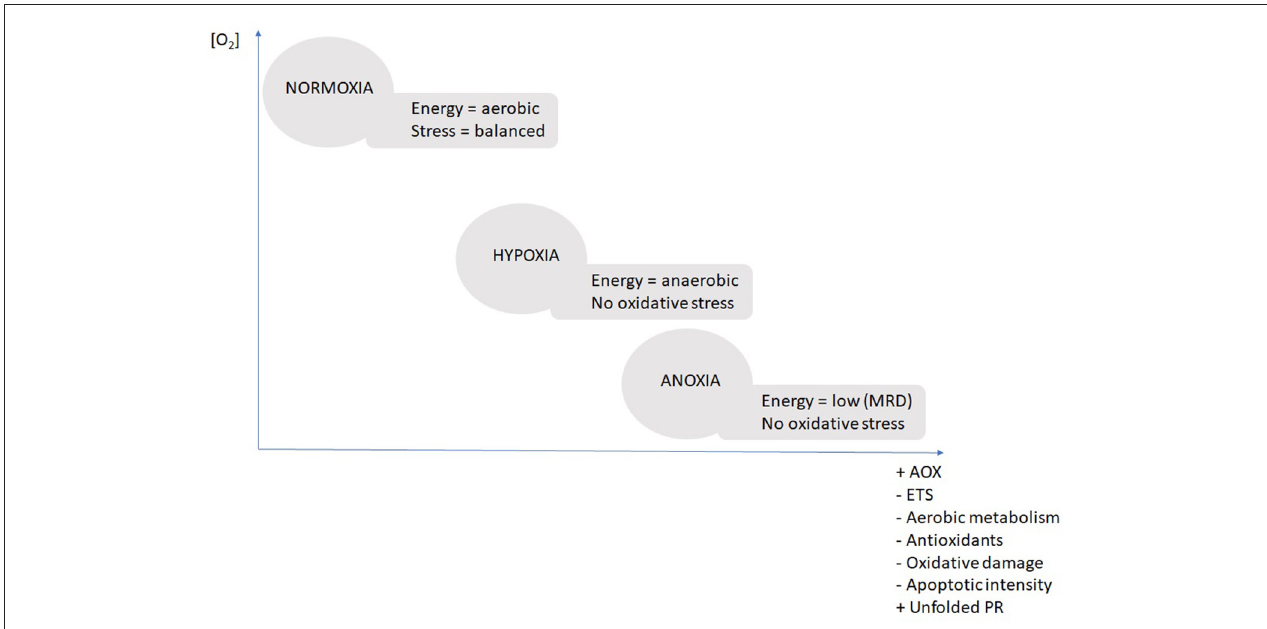
FIGURE 3 | Schematic diagram summarizing the major physiological mechanisms of adaptation to different oxygenation scenarios. Scenarios “normoxic,” “hypoxic,” and “anoxic” are based on evidence from the present study. AOX, alternative oxidase; ETS, electron transport system of complex I and III; unfolded PR, unfolded protein response; MRD, metabolic rate